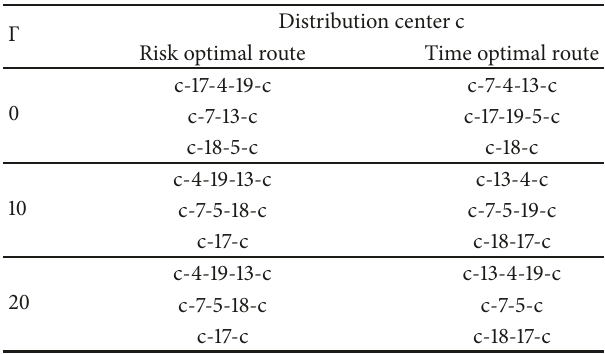
Table 16: Pareto optimal solutions for distribution center c when Γ = 0, Γ = 10 and Γ = 20.